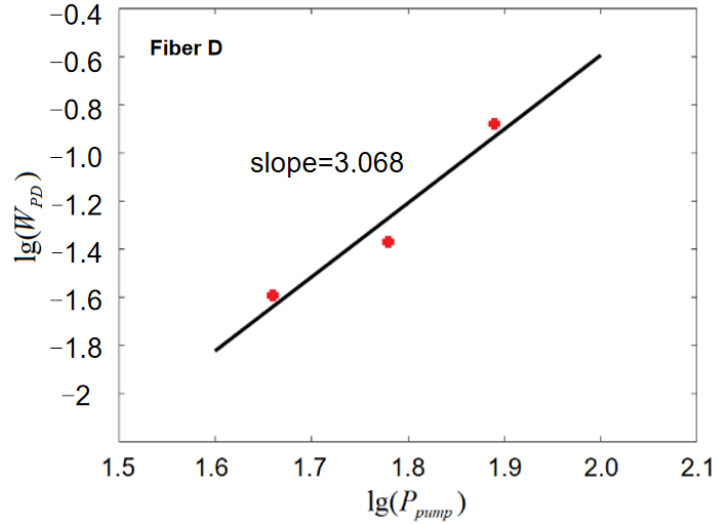
Figure 7. Logarithmic relationship between PD rate and pump power of Fiber D. According to Formula (11), the α PD , max ( T ) is related to the core temperature T . Since there is no temperature control device in the experiment, the main heat source is from the pump. From Figure 8, T is found to have a positive correlation with α PD , max ( T ) . T is calculated by the finite element method.